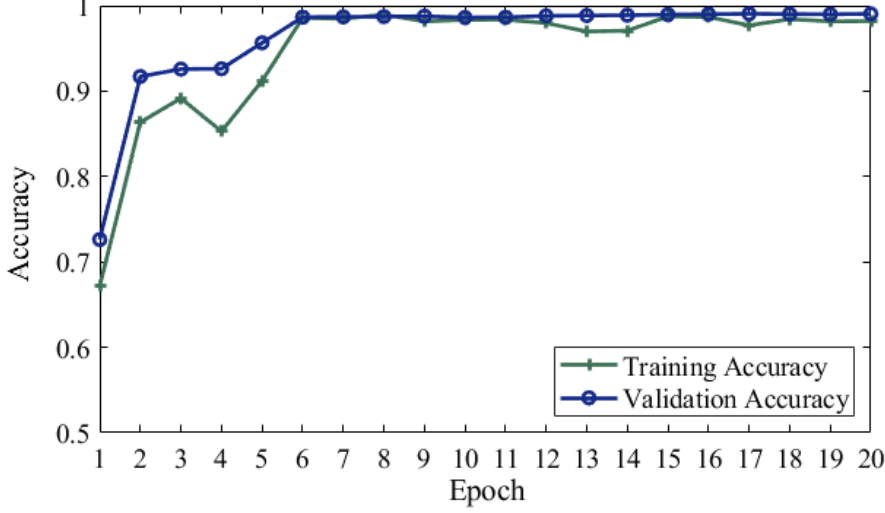
Figure 3. Proposed model training and validation accuracy.